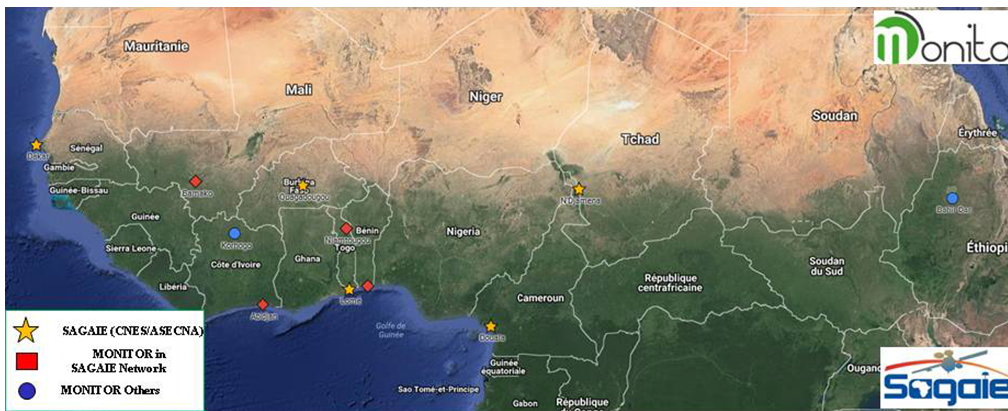
Figure 1. The MONITOR + SAGAIE network (low latitudes).